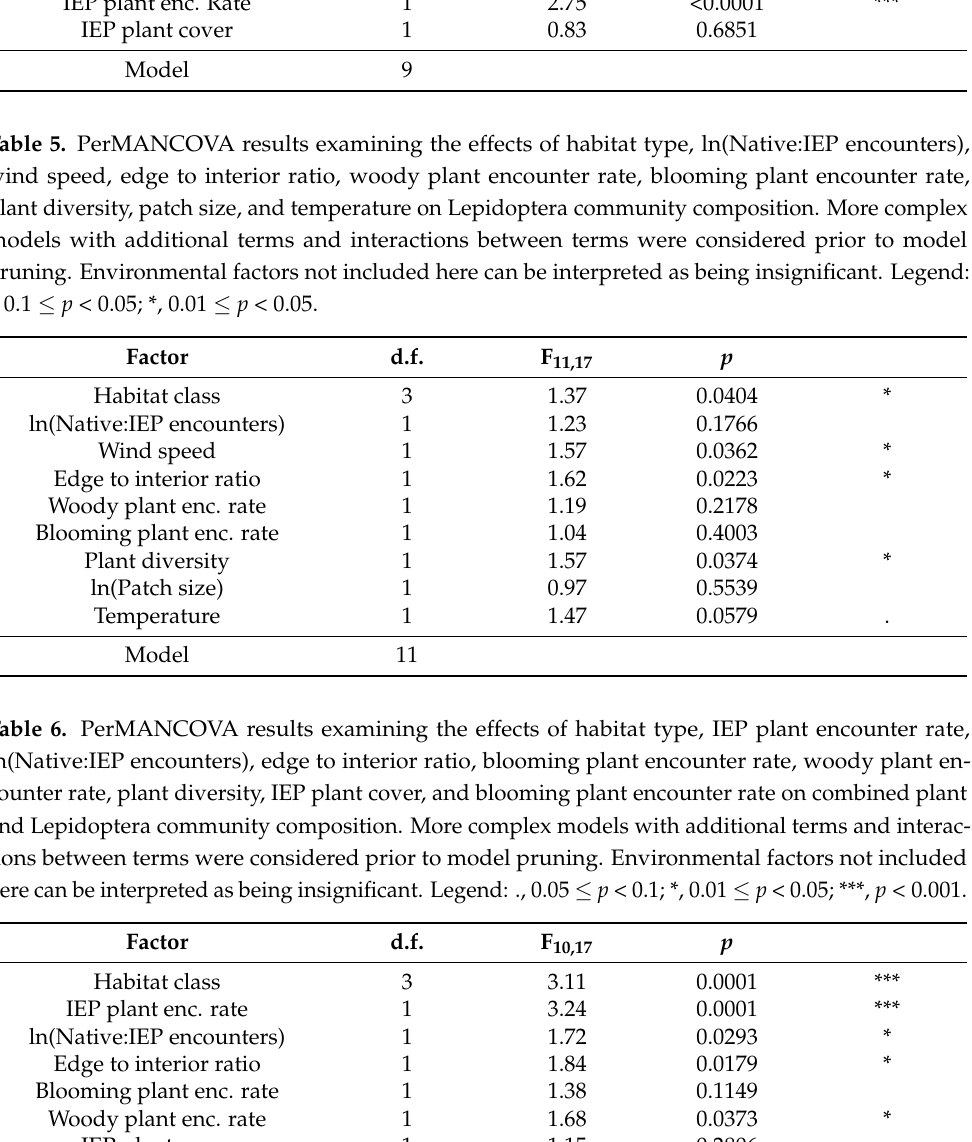
Table 4. Permutational multiple analysis of covariance (PerMANCOVA) results examining the effects of habitat type, patch size, edge to interior ratio, woody plant encounter rate, ln(Native:IEP encounters), IEP plant encounter rate, and IEP plant cover on plant community composition. More complex models with additional terms and interactions between terms were considered prior to model pruning. Environmental factors not included here can be interpreted as being insignificant.